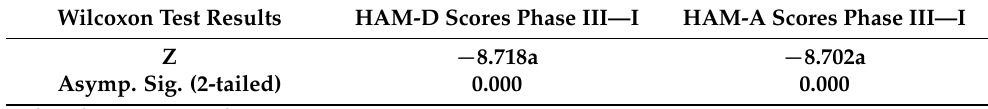
Table 6. Further statistical analysis of score distributions.